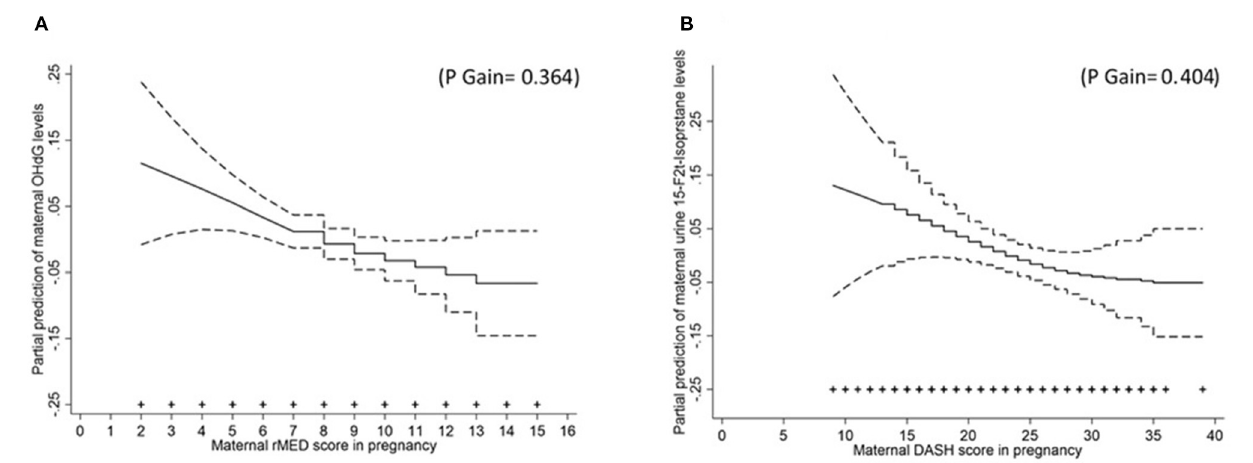
Offspring** Carbonyl groups (nmol/mg)